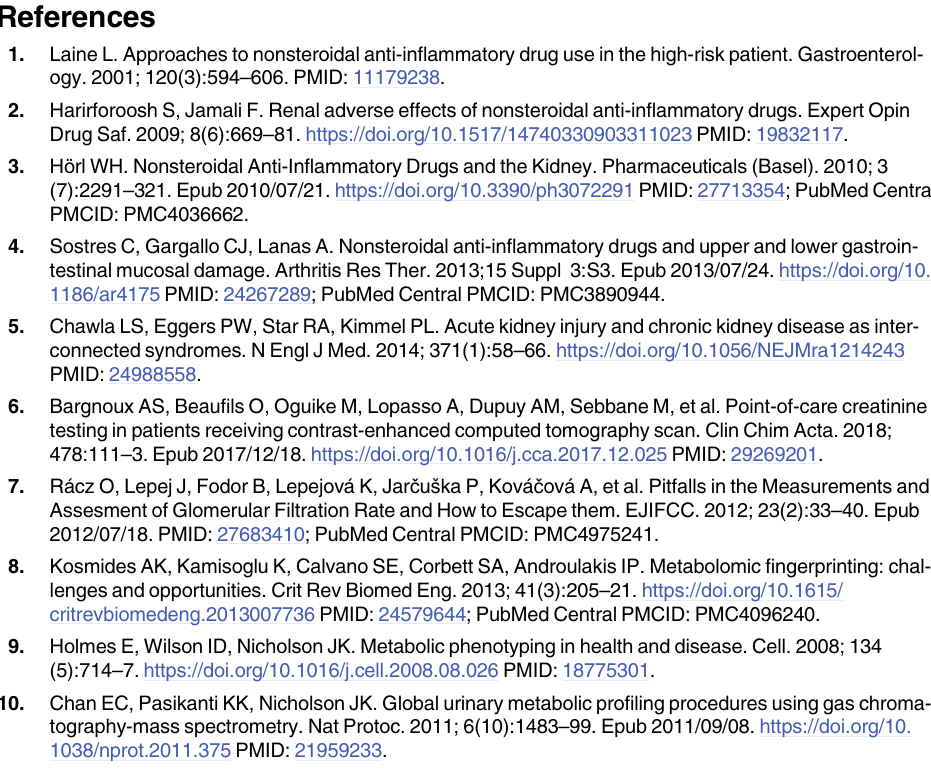
S5 Table. List of average, maximum, and minimum raw intensity values (m/z) obtained from GC-MS assay for each time point. The list of identified metabolites is derived from training data set urine collected from control cats treated with saline (n = 6) or meloxicam (n = 5) at 0.3 mg/kg every 24 hrs for up to 17 days (time point 5). Values highlighted in red indicate an increase in average intensity ( > 1.2 fold) and values highlighted in yellow represent a decrease in average intensity ( < 0.8) when comparing the meloxicam treated group vs. the saline treated control